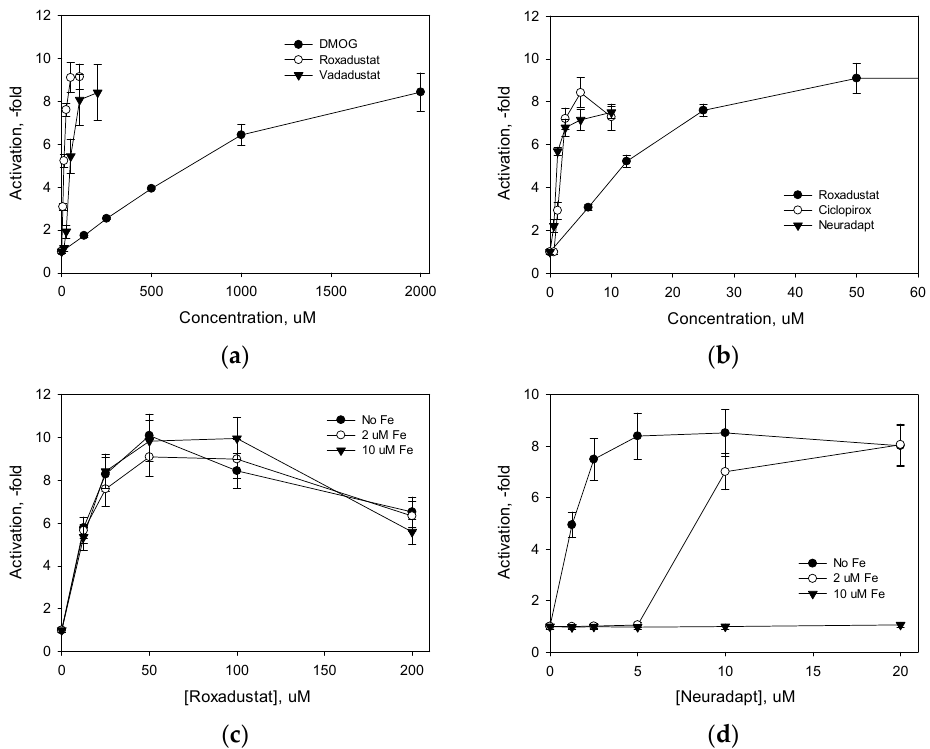
Figure 2. Potency of HIF prolyl hydroxylase inhibitors in HIF1 ODD-luc reporter assay ( a , b ), the effect of exogenous iron on reporter activation by roxadustat ( c ), and neuradapt ( d ). Assay conditions under Materials and Methods.